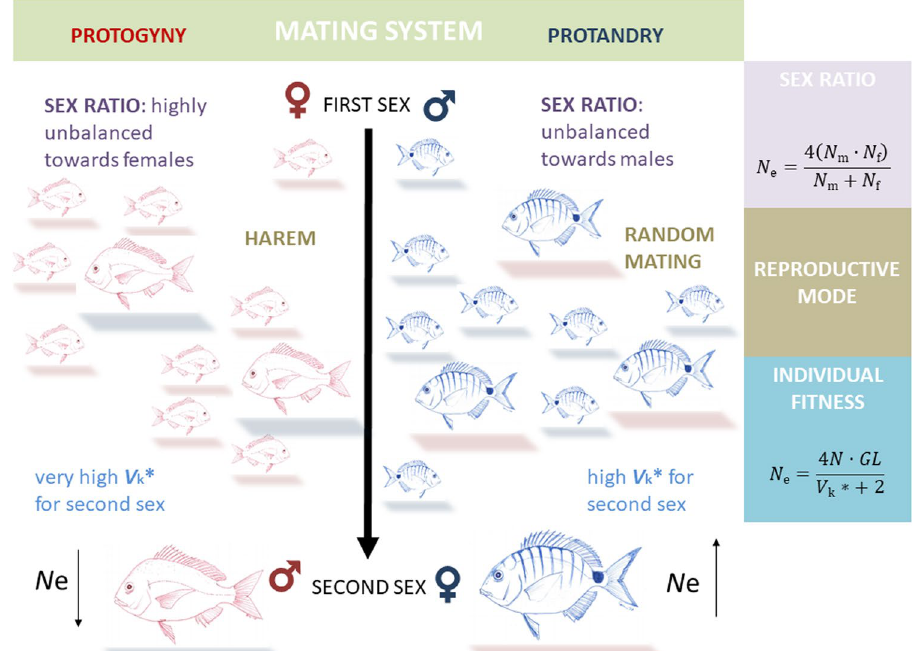
Figure 1. Interplay among individual fitness, life-history traits and population dynamics. Multiple factors affect effective population size ( N e ), including many driven by the mating context of the population. The exemplified protogynous species is drawn in red and the protandrous one in blue; shadows indicate the sex of individuals at any point during their lives (red for females; blue for males). In the equations: N m = number of adult males; N f = number of adult females; N = total number of adults in the population; GL = generation length; V k * = variance in individual lifetime reproductive